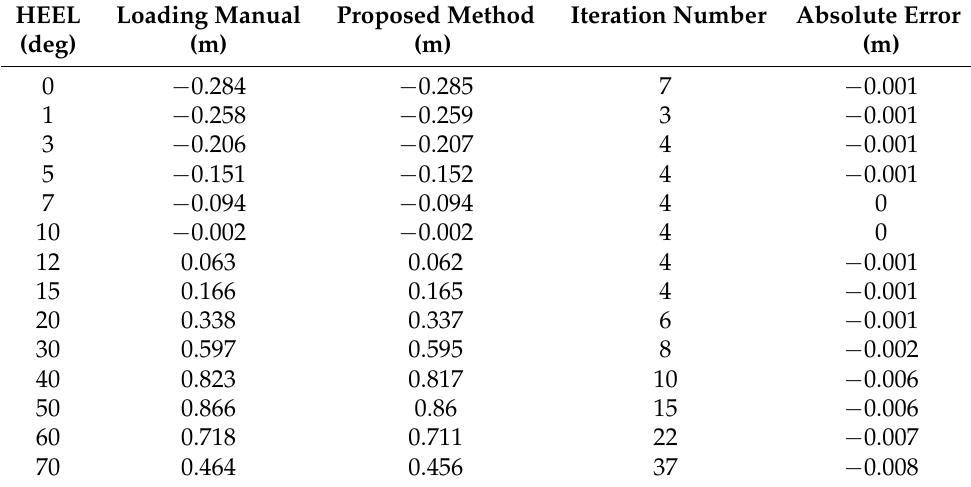
Table 10. GZ calculation result of